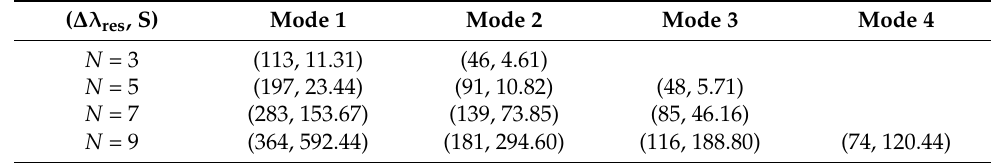
Table 3. Comparison of ( ∆ λ res (nm), S(nm/MPa)) of the designed structure for N = 3, 5, 7, and 9.